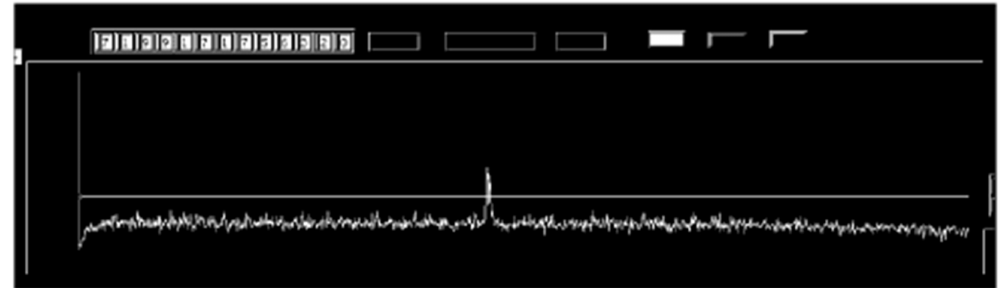
Figure 21. Example of an echo of an unknown object received by the Medicina-Evpatoria bistatic system in 2007 [46]. Reprinted from Memorie della Societ à Astronomica Italiana Supplementi, Copyright 2008, with permission from SAIt.